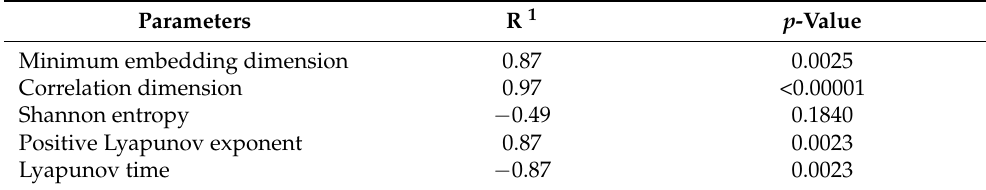
Table 2. Correlation analysis of minimum embedding dimension, correlation dimension, Shannon